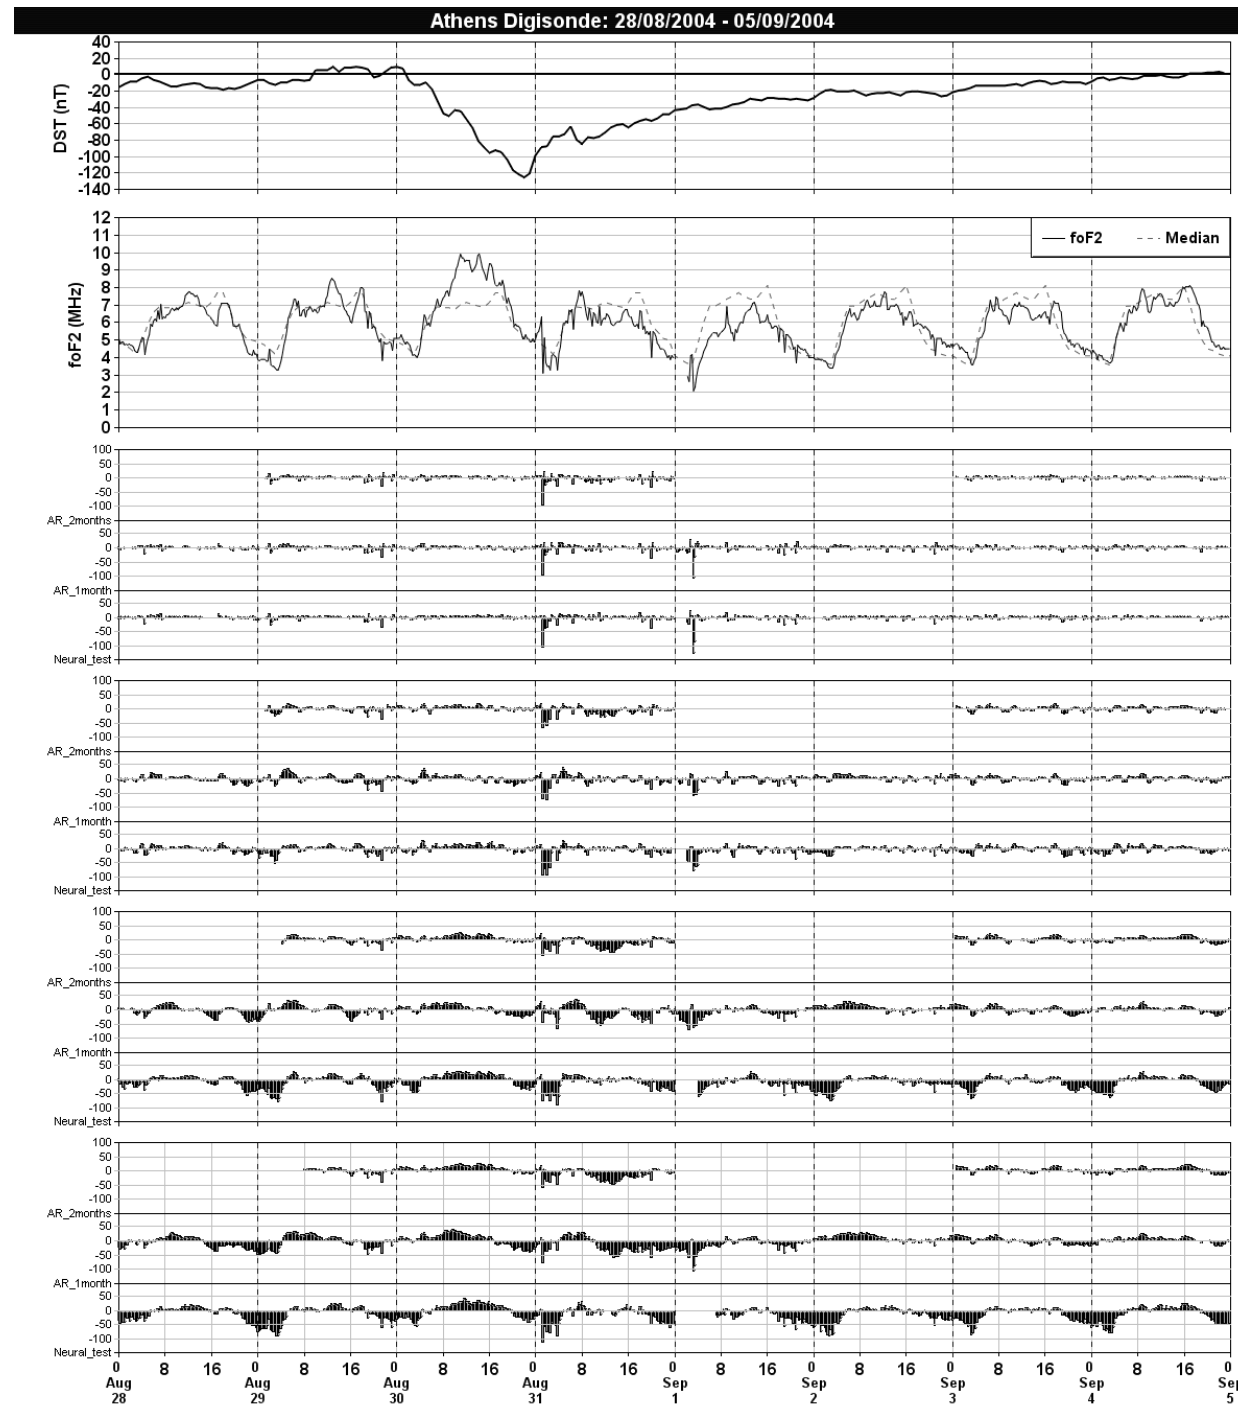
Fig. 2. The Dst index is presented in the top panel followed by the observed f oF 2 parameter from Athens Digisonde and its monthly median value (dashed line), for the storm interval 28 August–4 September 2004. The prediction error parameter is presented in the last four panels for 15min, 1hr, 3h and 6h prediction window. In each panel the prediction error is calculated using the results of the three models under discussion, TSAR2, TSAR1 and